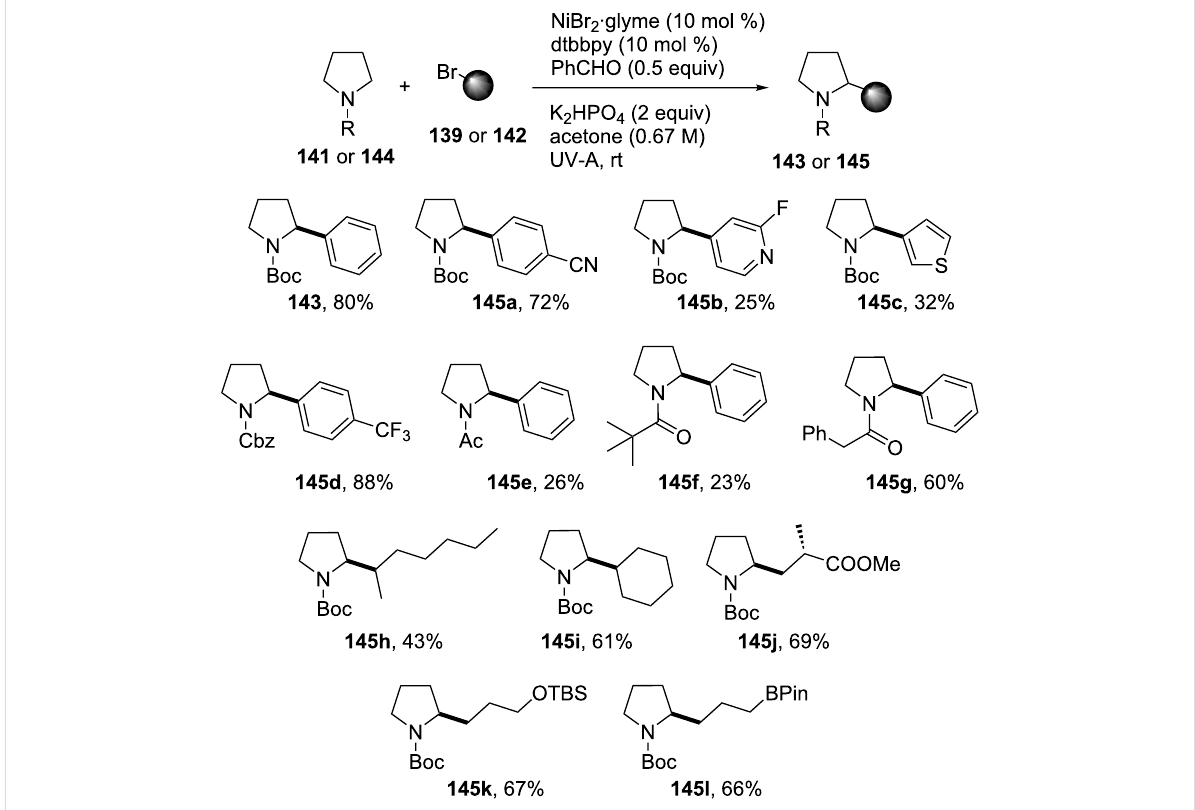
Scheme 32: Substrate scope for the photochemical alkylation of N-containing molecules.